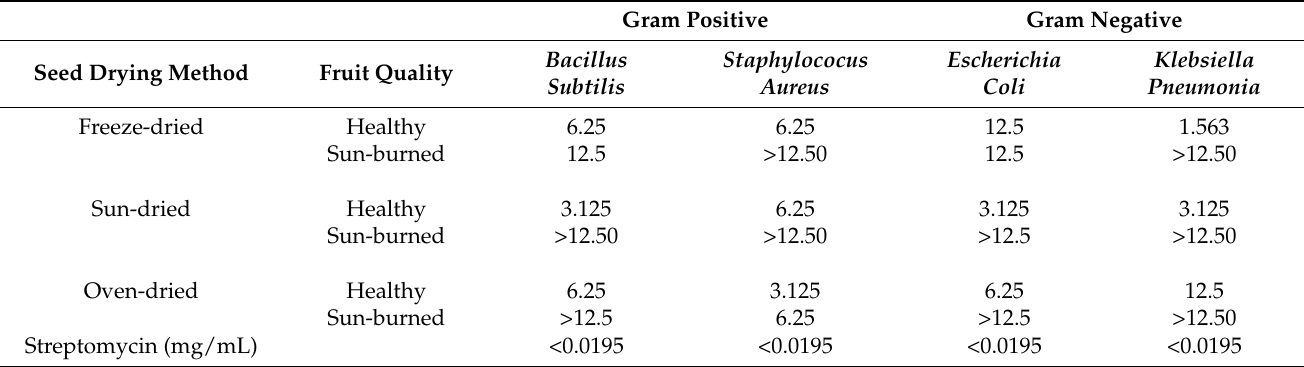
Table 2. Antimicrobial activity (MIC, mg/mL) of oil from seeds of healthy and sun-burned fruits and dried under different drying